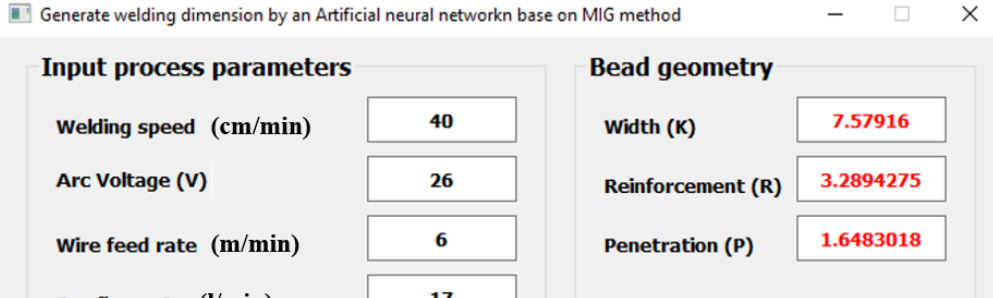
Figure 12. Screenshot of the SMAW welding module of the developed predictive system. 3.2. Testing and Evaluating the Functionality of the Developed Predictive System The functionality of the developed system was tested successfully. The predicted results are reliable in comparison with the experimental results and the calculated results. Table 10 shows the prediction results of the developed system for the TIG welding process, in which P-K T , P-R T , and P-P T are the predicted weld bead width, reinforcement, and penetration, respectively. C-K T , C-R T , and C-P T are the weld bead width, reinforcement, and penetration calculated by using Equations 7, 8, and 9, respectively. Dev. of K T , Dev. of R T , and Dev. of P T are the deviations between the prediction and calculation results of the weld bead width, reinforcement, and penetration, respectively. The % of K T , % of R T , and % of P T are the deviations between the prediction and calculation results of the weld